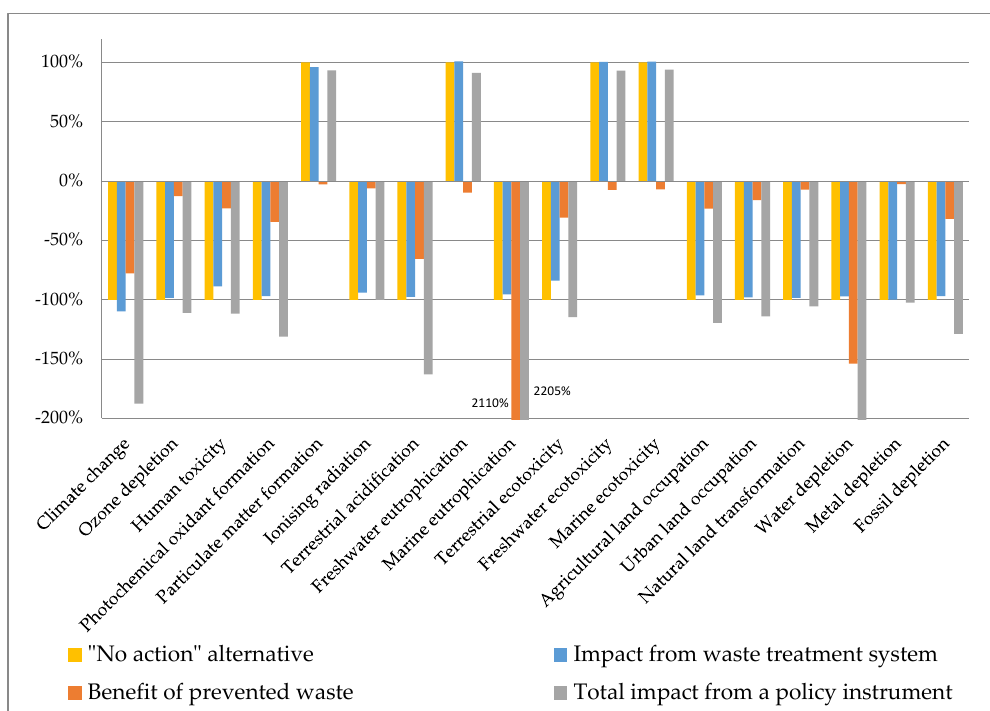
Figure 5. Relative environmental impacts from Weight based waste fee, alt.1 in comparison to the “no action” alternative. The “no action” alternative is set to 100%.